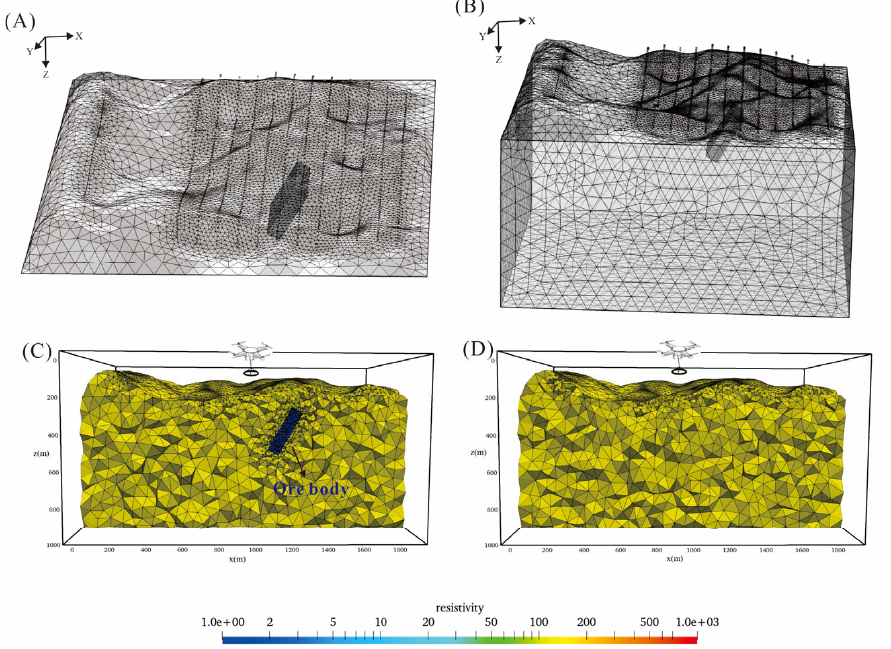
Figure 5. Forward and inverse models for an inclined ore body model. ( A , B ) show the locations of the source, survey points and the inclined ore body, ( C ) is the discretization of the inclined model for forward modeling, ( D ) is the discretization of the model for inversion.